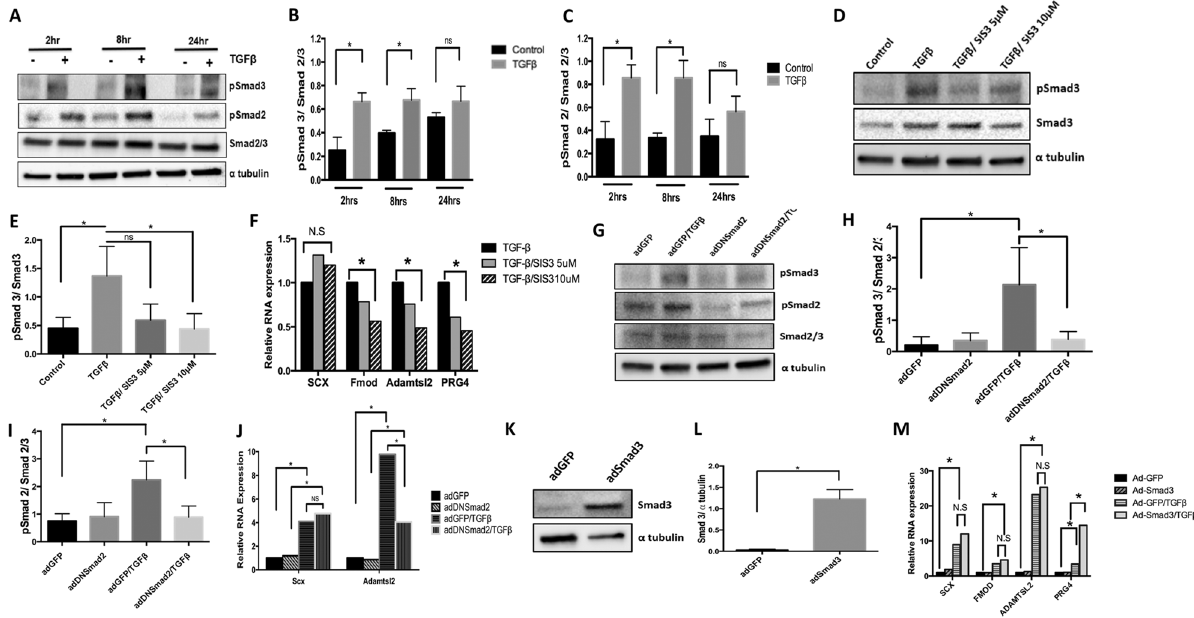
Figure 2. Smad3 is required for TGF-β to regulate expression of Fmod and Adamtsl2. ( A ) Primary sclerotome was treated with vehicle control or TGFβ1 for 2 h, 8 h or 24 h. Immunoblot was used to determine the levels of pSmad3, pSmad2 and total Smad2/3. α-Tubulin was used as a general loading control. ( B ) Quantification of pSmad3 and ( C ) pSmad2 levels relative to total Smad2/3 are shown. Immunoblots were quantified using ImageJ. (*) indicates significance, p < 0.05, n = 3 for each ( D ) Sclerotome was pretreated with vehicle control or SIS3 (5 µM and 10 µM) for 24 h and then treated with or without TGFβ1 for 8 h. pSmad3 and Smad2/3 protein levels were analyzed via immunoblot. α-Tubulin was used as a general loading control. ( E ) Smad3 activity was quantified from the immunoblots using ImageJ as the relative levels of pSmad3 normalized to total Smad2/3. (*) indicates significance, p < 0.05, n = 3 ( F ) Relative levels of Scx, Fmod, Adamtls2 and Prg4 mRNA were determined by qPCR after indicated treatment with SIS3. All mRNA levels were normalized to the housekeeping gene Hprt and then analyzed for significance using REST (*). Results are shown relative to TGFβ1 treated cells. n = 3 ( G ) Cells were infected with AdDNSmad2 or AdGFP control virus 48 h before cells were treated with or without TGFβ1 for 8 h. Immunoblot was used to visualize relative levels of pSmad3, pSmad2 and total Smad2/3. α-Tubulin is shown as a general loading control. ( H ) pSmad3 and ( I ) pSmad2 activity were quantified using ImageJ as the level of each phosphoSmad normalized to total Smad2/3. (*) indicates significance, p < 0.05, n = 3 ( J ) RNA was extracted from cells that were infected with AdDNSmad2 or AdGFP and treated or untreated with TGFβ1. Relative levels of Scx and Adamtsl2 mRNA were determined by qPCR. Expression was normalized to the housekeeping gene Hprt. Results are shown relative to the untreated control (*) indicates